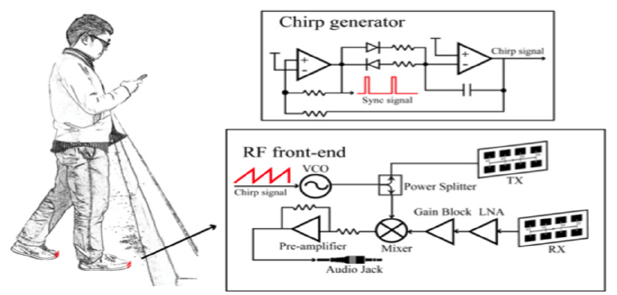
Figure 4. Using an FMCW radar for fall prevention. Reprinted with permission from Ref. [107]. Copyright 2016, IEEE.